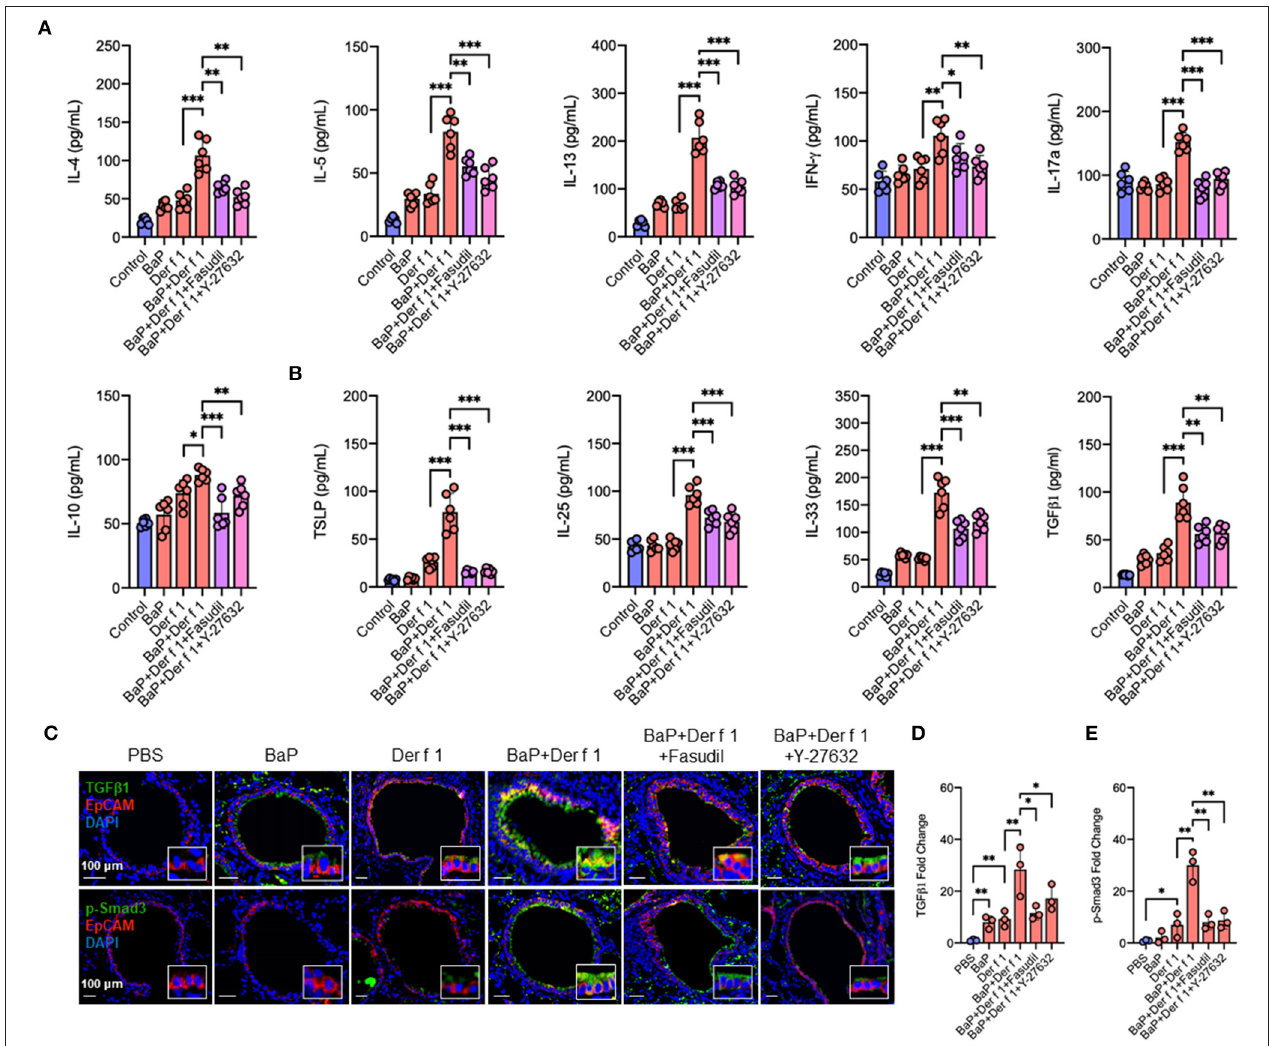
FIGURE 7 | Inhibition of RhoA suppresses BaP co-exposure-induced cytokine production. (A,B) Levels of Th1/Th2/Th17 inflammatory cytokines (A) and airway epithelial cell-derived cytokines (B) in the bronchoalveolar lavage samples of mice treated with either Fasudil or Y-27632. (C) Representative immunofluorescence images of TGF β 1 (green, upper panel) and p-Smad3 (green, lower panel) expression in the airway epithelial cells (EpCAM, red) of an asthma mouse model. (D,E) Quantitative analysis of fluorescent-positive cells in the tissue sections for TGF β 1 (D) and p-Smad3 (E) in at least four different high-power fields (500 µ m 2 ) in two to three different lung sections per mouse by using Fiji ImageJ. Data represent mean ± SEM ( n = 6 mice/group). * p < 0.05, ** p < 0.01, and *** p <